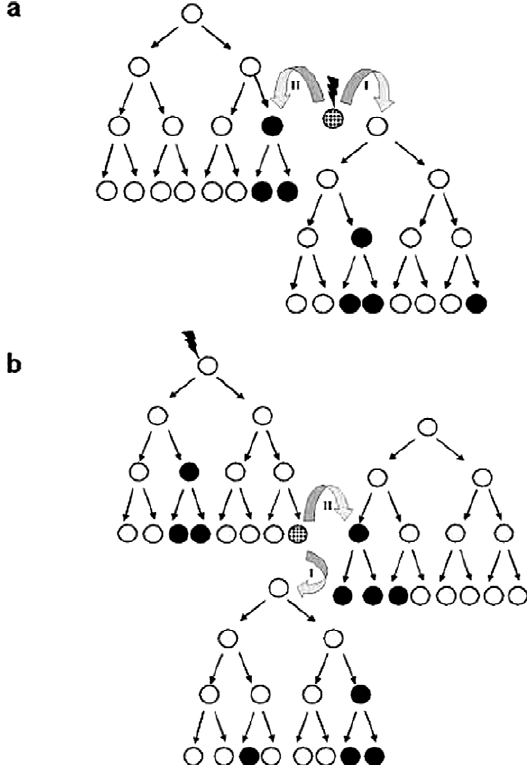
Fig. 2. Models of the inter-relationship between radiation-induced genomic instability in haemopoietic tissues [23,26] with mutations and/or chromosomal aberrations shown as filled circles and appar- ently normal cells as open circles and an ‘activated cell’ capable of producing a bystander signal as a hatched circle. (a) A bystander signal may induce a transmissible genomic instability or a damage response in an unirradiated clonogenic cell (I) or in a cell that has descended from an unirradiated clonogenic cell (II). In this model, instability may be a consequence of bystander signalling from an ‘activated cell’ and bystander effects may initiate and be responsible for radiation-induced genomic instability. (b) Radiation-induced ge- nomic instability transmitted from an irradiated clonogenic cells may result in an ‘activated cell’ capable of inducing a bystander-mediated transmissible genomic instability or a damage response in an unir- radiated clonogenic cell (I) or in a cell that has descended from an unirradiated clonogenic cell (II). In this model, radiation-induced ge- nomic instability produces cells that provide a bystander signal able to induce instability; i.e. bystander effects can be both a cause (a) and/or a consequence (b) of inducible